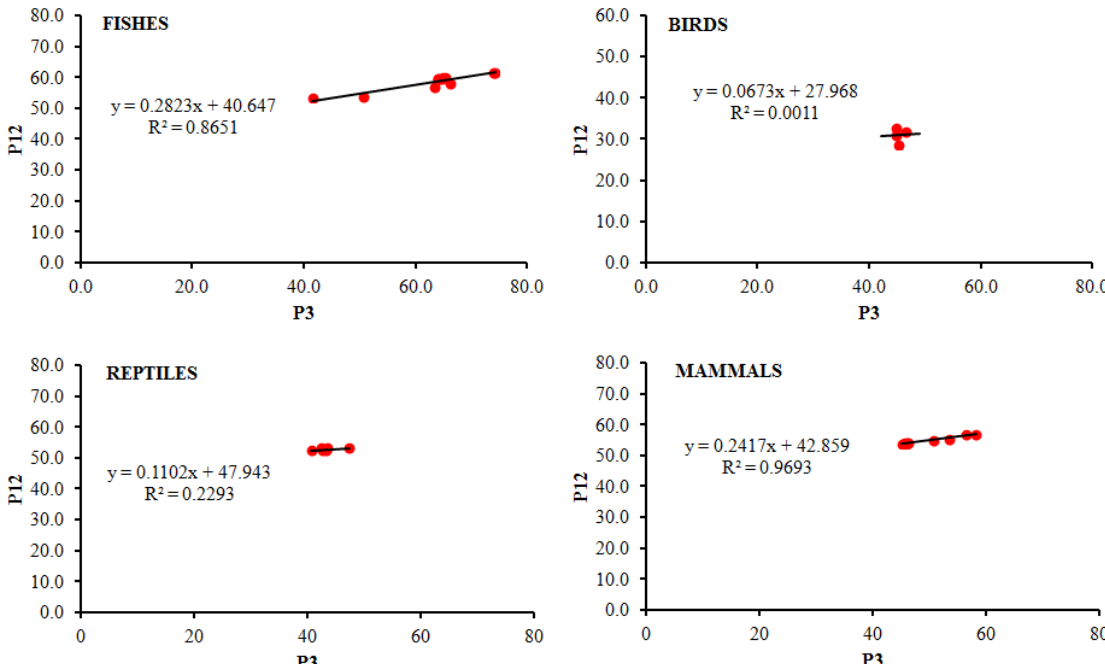
Figure 5. Neutrality plot (P12 versus P3) in the coding sequence of Foxp2 gene among different species of fishes, birds, reptiles, and mammals. The values of P3 were plotted on X -axis and P12 (the average of P1 and P2) was plotted on Y -axis. Black line is the linear regression of P12 versus P3.